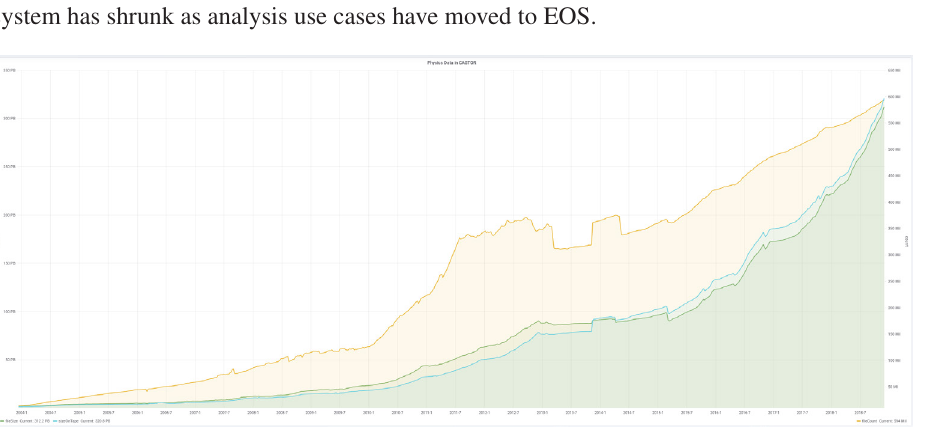
Figure 3. Castor